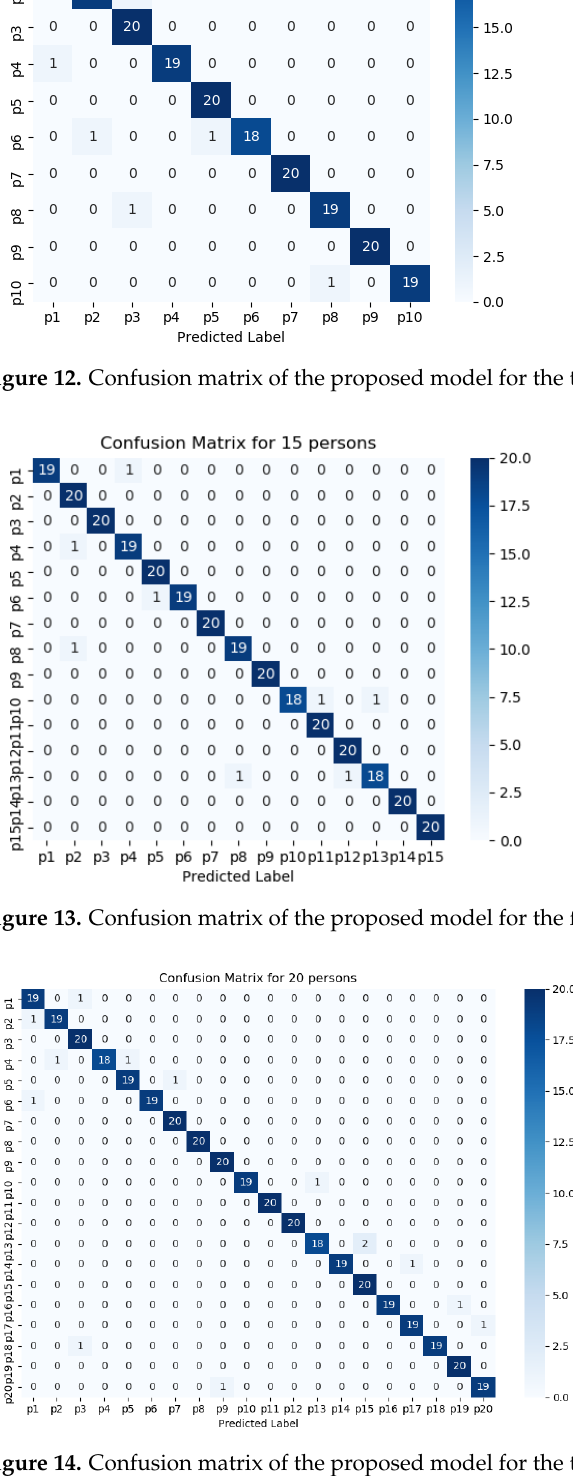
Figure 14. Confusion matrix of the proposed model for the twenty persons.